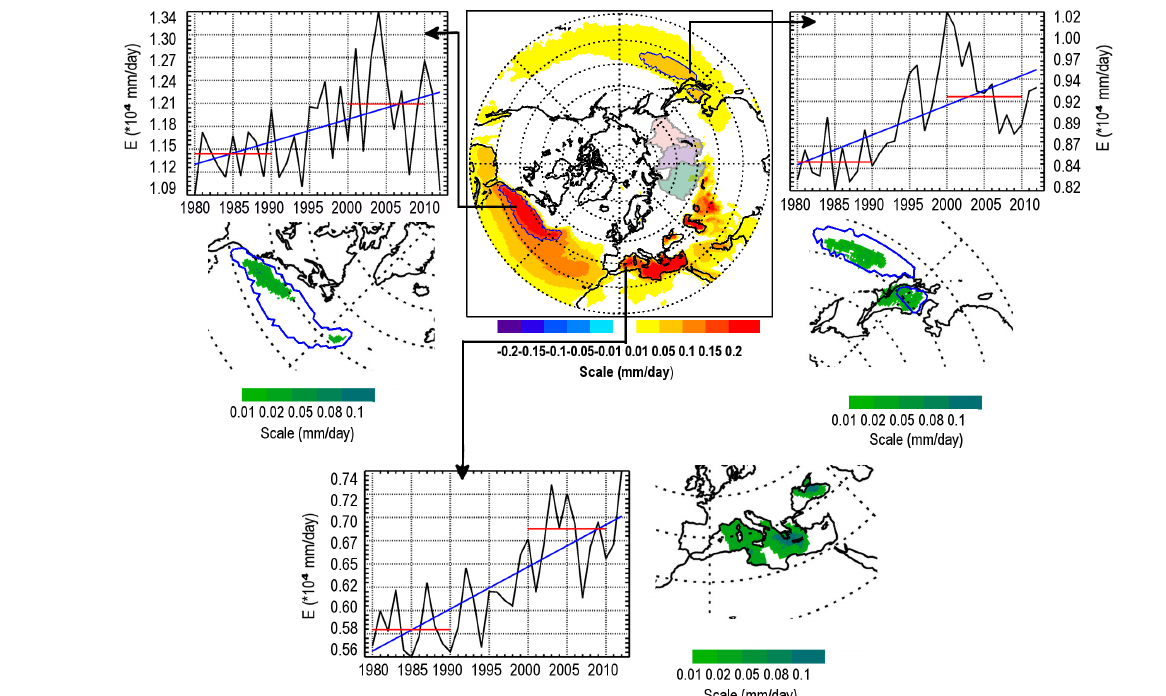
Figure 1. Centre panel: climatological October–March 10-day integrated ( E − P ) values observed for the period 1979–2012, for all the particles bound for the Ob, Yenisei and Lena river basins (green, purple and pink areas respectively indicate the basin area), determined from backward tracking. Warm colours represent regions acting as moisture sources for the tracked particles. Plots in green show the significant positive differences at the 95% level after bootstrap test (1000 interactions) in the composites of the moisture sources of the Arctic river basins between the decades 2001–2010 and 1981–1990. Temporal series show the evolution of the average evaporation derived from OAFlux data set for the main moisture sources for the Arctic river basins (the Atlantic and Pacific sources, those circled with a blue line in the central figure, and for the whole Mediterranean Sea basin). The blue lines are the linear trend and the red ones denote the 10-year periods used on